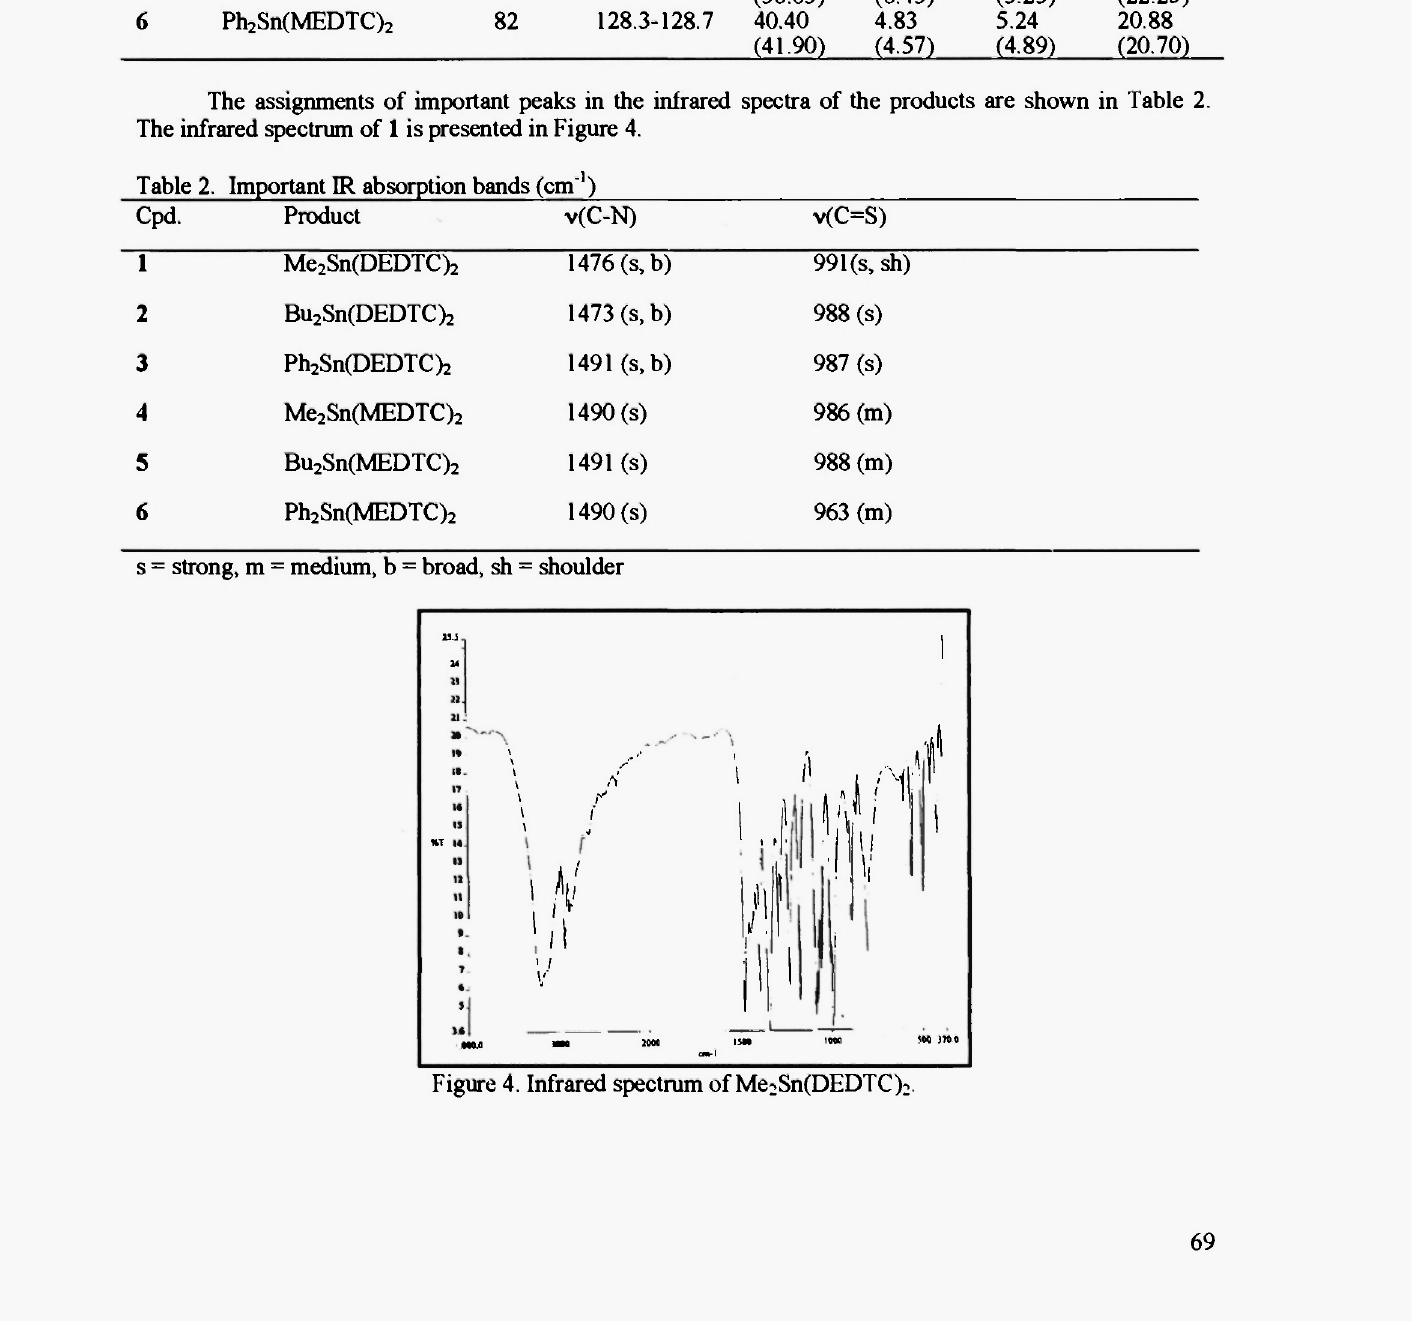
Figure 4. Infrared spectrum of Me 2 Sn(DEDTC) 2